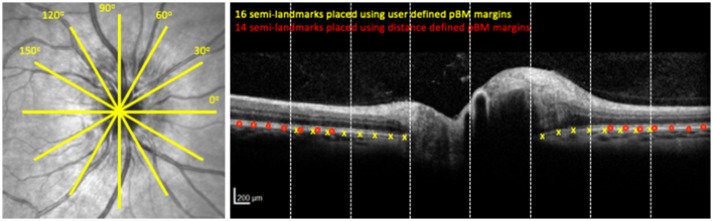
OCT image acquisition pattern and image analysis. Left panel shows the location of cross sectional OCT scans through the optic nerve head. Each yellow line is a cross section. Right panel shows the OCT cross sectional image at 0° for the optic nerve head shown on the left. Yellow x's indicate semi-landmark placement using the User-16 strategy. Red circles indicate semi-landmark placement using Distance-14 strategy. Dashed vertical lines show boundaries of segments for purposes of image reliability assessment.